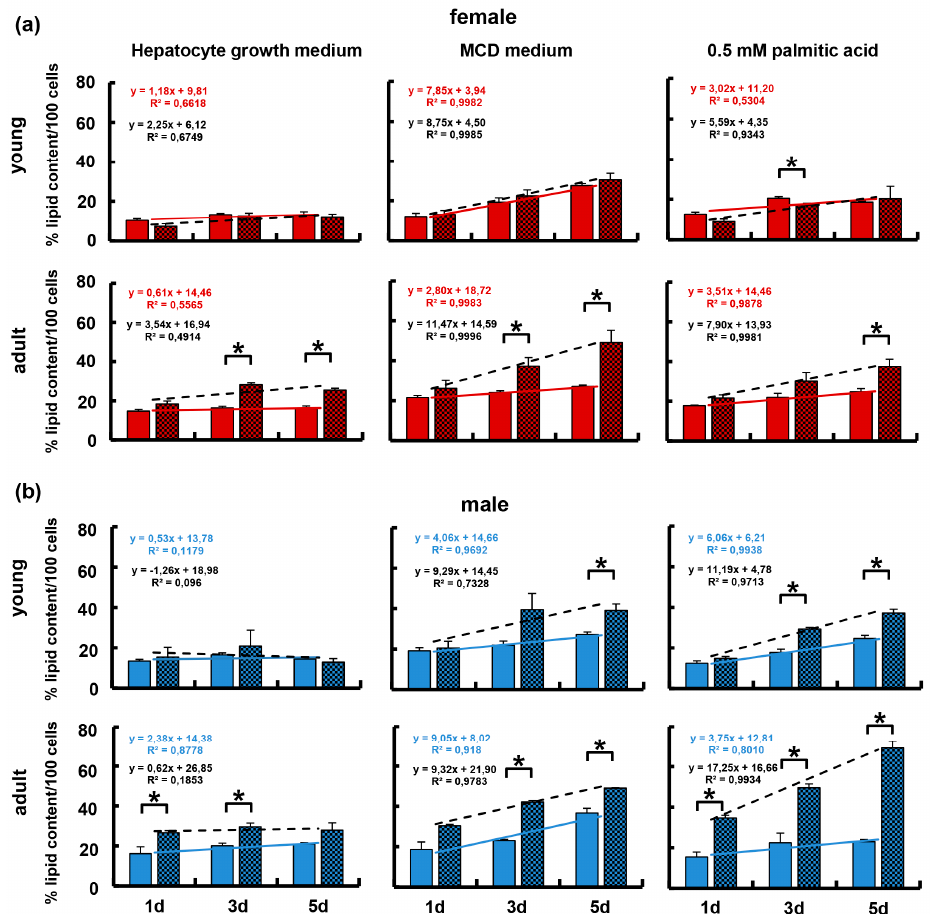
Figure 6. Lipid accumulation by isolated hepatocytes from wildtype and knockout, female and male mice. Hepatocytes were cultured either in hepatocyte growth medium HGM (left panels), or steatosis-inducing MCD medium (middle panels), or in HGM supplemented with 0.5 mM palmitic acid (right panels). In ( a ), wildtype female young and adult mice are shown as solid columns with solid trend lines, equations and coefficients of determination (upper values); knockout female young and adult mice are shown as hatched columns with hatched trend lines, equations, and coefficients of determination (lower values). In ( b ), wildtype male young and adult mice are shown as solid columns with solid trend lines, equations, and coefficients of determination (upper values); knockout male young and adult mice are shown as hatched columns with hatched trend lines, equations, and coefficients of determination (lower values). Hepatocytes were cultured for the times indicated and lipids stained with Oil Red O. Quantification was performed by image analysis and values normalized as the percentage amount of stain per 100 cells. Horizontal lines marked with an asterisk indicate significant differences at the p ≤ 0.05 level.